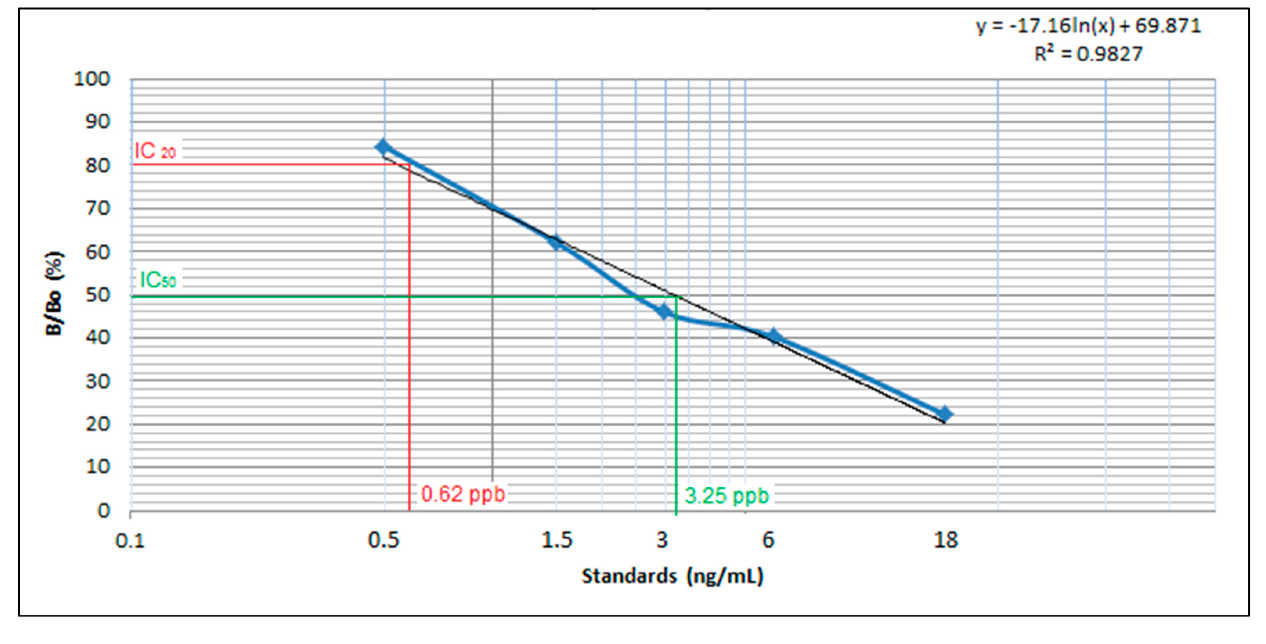
Figure 4. Calibration curve for tetracycline detection in beef muscle and milk by ELISA.